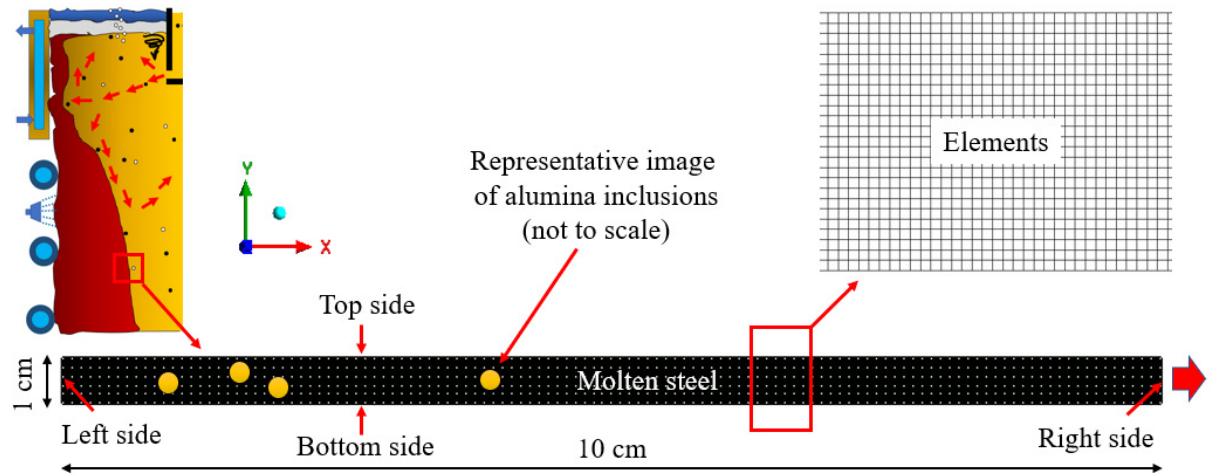
Figure 4. A small-scale domain considered for the study of motion of an inclusion.